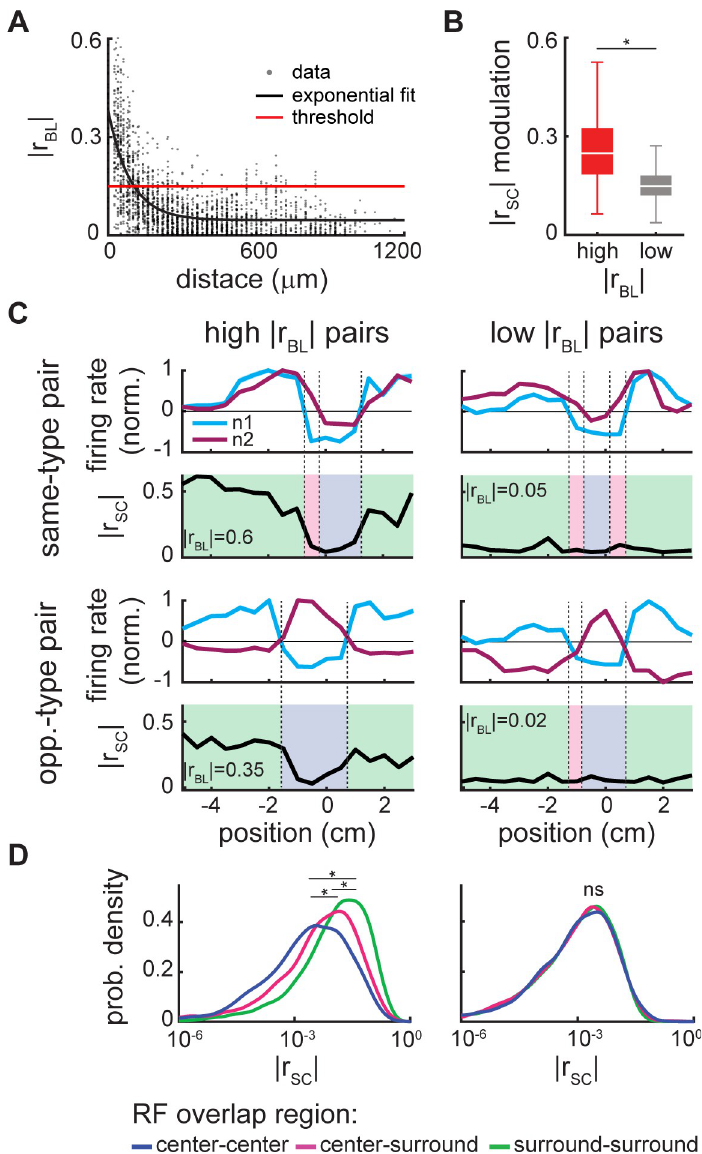
Fig 5. Spatial modulation of spike-count correlations depends on the level of baseline correlations. (A) Magnitude of pairwise baseline correlations (|r BL |; black circles) as a function of the relative distance between neurons with a fitted exponential curve (black line). A threshold of |r BL | = 0.15 (red line) was used to separate neural pairs into high and low |r BL | pairs. (B) The spatial depth of modulation (max.-min.) of the spike-count correlations (|r SC |) is significantly higher for high |r BL | pairs than for low |r BL | pairs across recording sessions (Wilcoxon rank sum test for b: p = 2.1 � 10 − 128 ; outliers were removed as detailed in the Materials and Methods section). (C) Spatial dependence of the |r SC | is shown for four example pairs, two same-type pairs (OFF-OFF type pairs) and two opposite-type pairs (ON-OFF type pairs) each with low and high |r BL |. For high |r BL | pairs (left column), the spatial dependence of the |r SC | (black) is determined by the region of receptive field overlap (receptive field neuron 1 blue, receptive field neuron 2 purple): in regions where the surrounds of both neurons overlap, the |r SC | approaches |r BL | (green background); in regions where the surround of one neuron overlaps the center of the other, the |r SC | is intermediate (pink background); and in regions where there is center-center overlap, the |r SC | approaches zero (blue background). In contrast, for low |r BL | pairs of either type (right column), there is minimal or no spatial modulation and the magnitude hovers near zero. (D) Distributions of |r SC | for regions of center-center (blue), center-surround (pink) and surround-surround overlap (green) pooled over all pairs across all recording sessions: for high |r BL | pairs (left) the three distributions are significantly different (Kruskal-Wallis: p = 1.8 � 10 − 131 ; cc-cs: p = 9.7 � 10 − 10 ; cc-ss: p = 9.6 � 10 − 10 ; cs-ss: p = 9.6 � 10 − 10 ); however, they are not significantly different for low |r BL | pairs (right; Kruskal-Wallis: p = 0.89; cc-cs: p = 0.94; cc-ss: p = 0.89; cs-ss: p = 0.99). “ � ” indicates statistical significance; ns, not significant; c, center; s, surround.